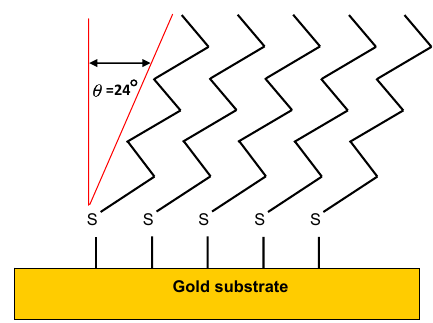
Figure 1. Proposed structure for the SAM.